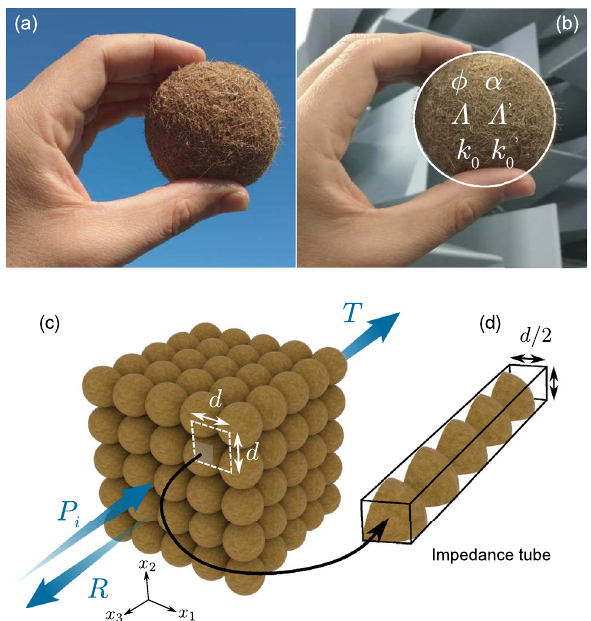
Figure 1. Aegagropilae ( a ) and its model as a porous sphere ( b ). ( c ) Principal cubic arragement of Aegagropilae used to construct the fully natural 3D sonic crystal. ( d ) Reduced model used for the scattering measurement in the impedance tube at normal